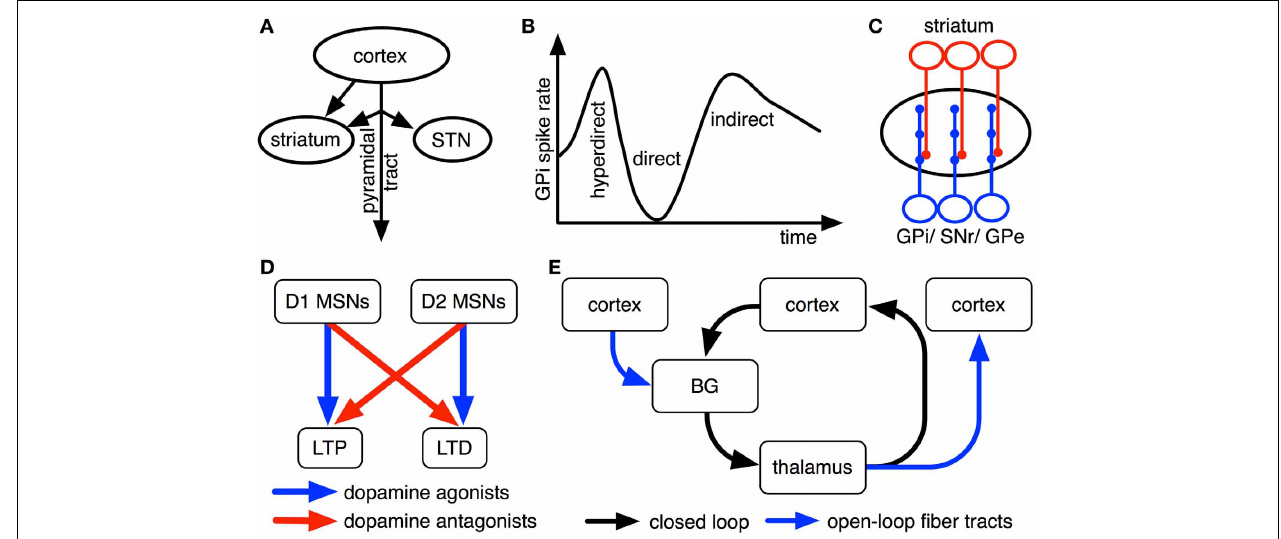
FIGURE 2 | Empirical findings that constrain interpretations on pathway functions. For illustrative purposes, all findings are shown as cartoons. (A) Striatum receives inputs from both intratelencephalically projecting cortical neurons and cortical pyramidal-tract neurons, while STN predominantly receives pyramidal-tract afferents (Donoghue and Kitai, 1981; Giuffrida et al., 1985; Lei et al., 2004; Parent and Parent, 2006; Kita and Kita, 2012). (B) Upon electrical stimulation of cortex, direct, indirect and hyperdirect pathways influence GPi activity with different latencies because